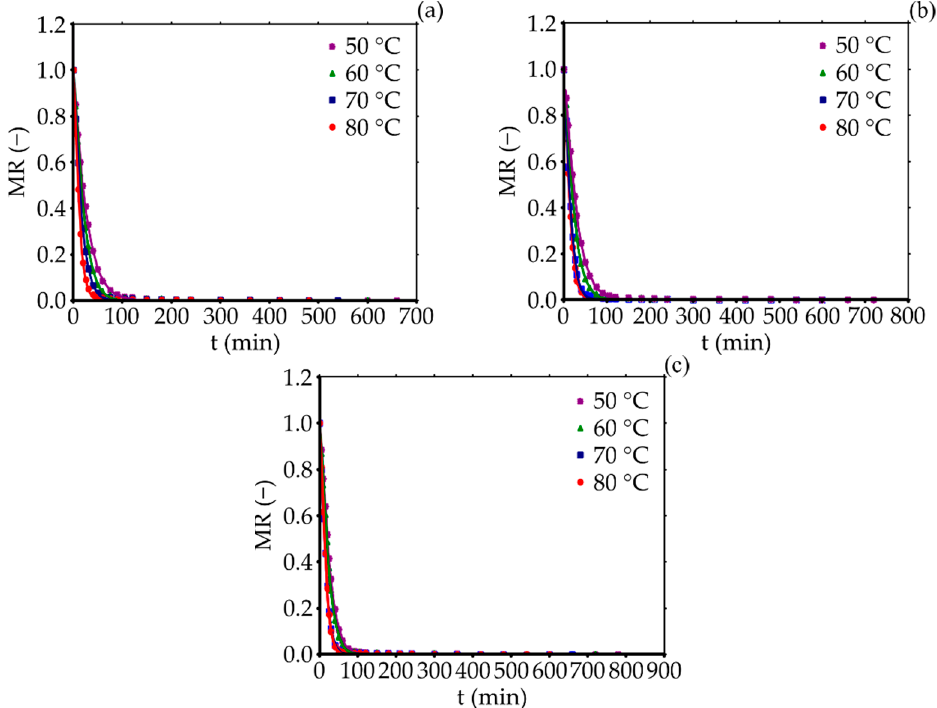
Figure 1. Experimental and estimated values by the Page model for the ratio of water content as a function of drying time of germinated faba bean seeds at temperatures of 50, 60, 70 and 80 °C: ( a ) OVP; ( b ) RS; and ( c ) B.